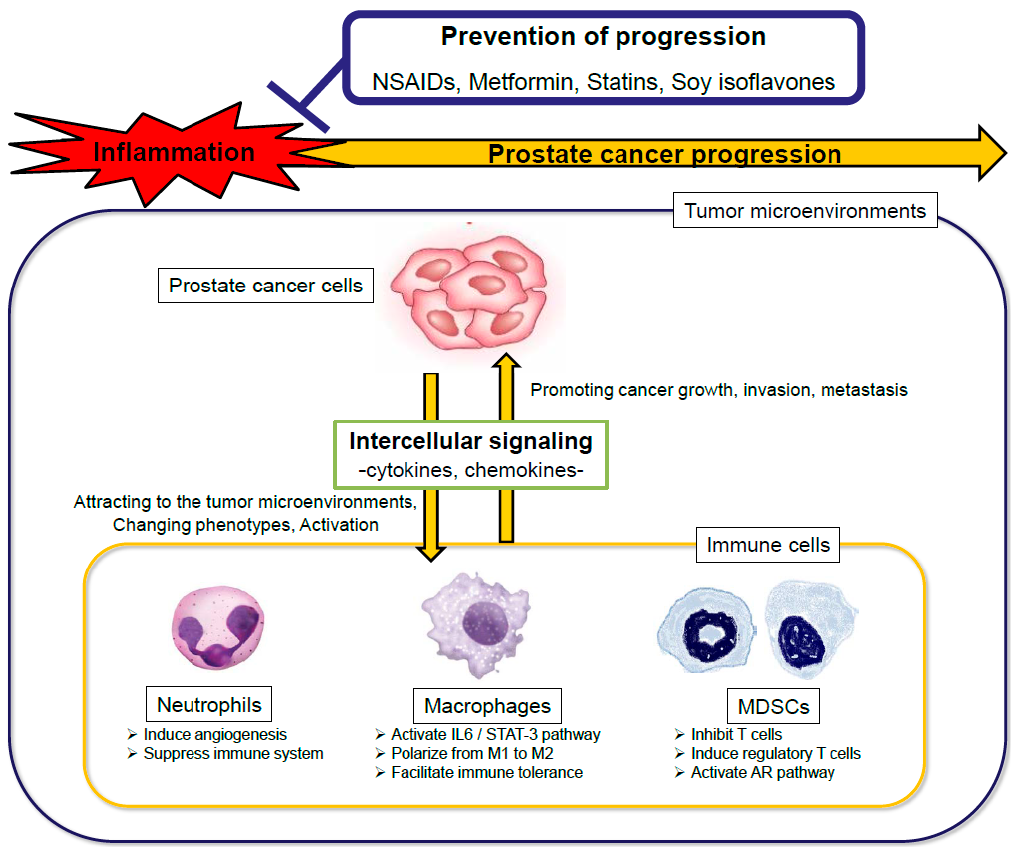
Figure 1. The scheme of the interactions of immune cells with prostate cancer progression and the interventions against inflammation. NSAIDs, non-steroidal anti-inflammatory drugs; IL, interleukin; STAT, signal transducer and activator of transcription; MDSCs, myeloid-derived suppressor cells; AR, androgen receptor.